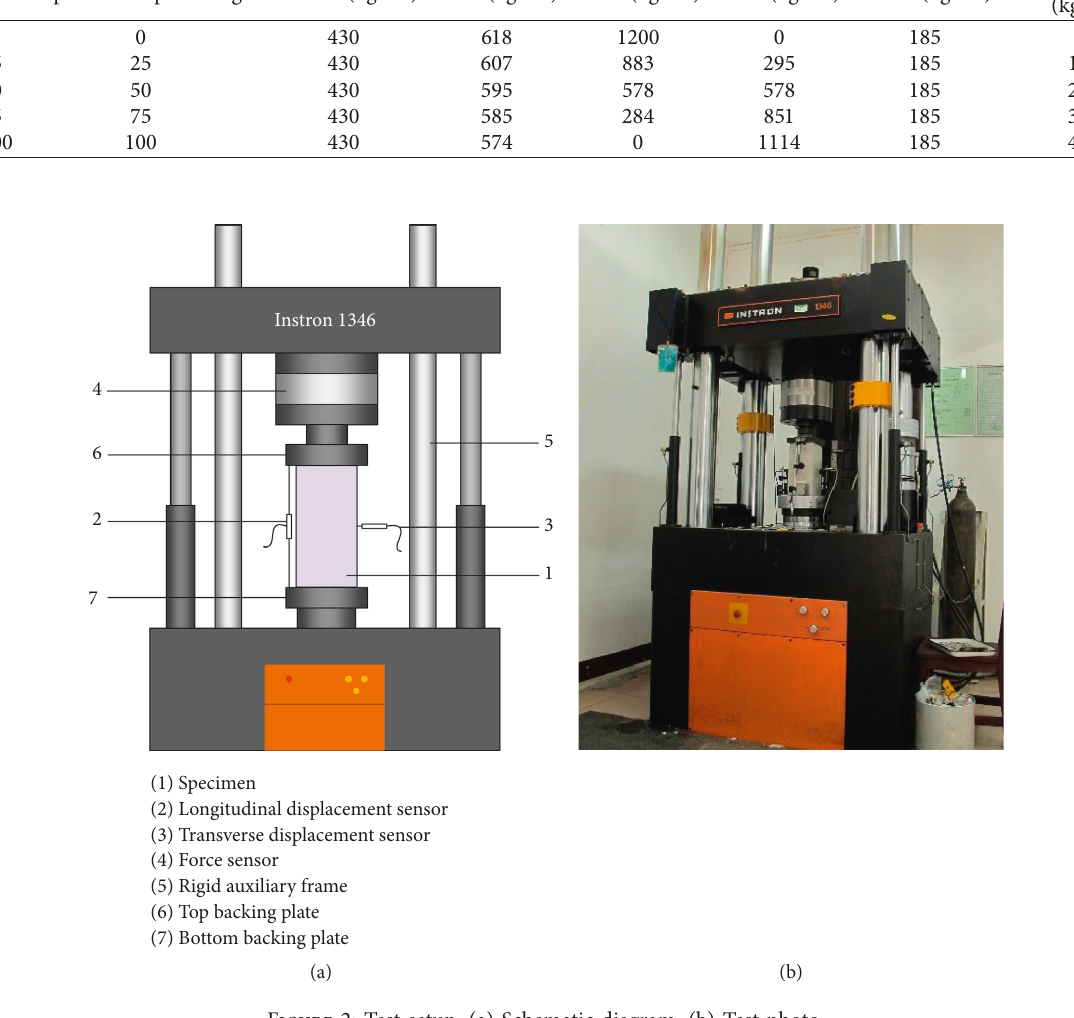
Table 2: Mix proportions of the RAC (reproduced from Hu et al. [24] (under the Creative Commons Attribution License/public domain)). No.